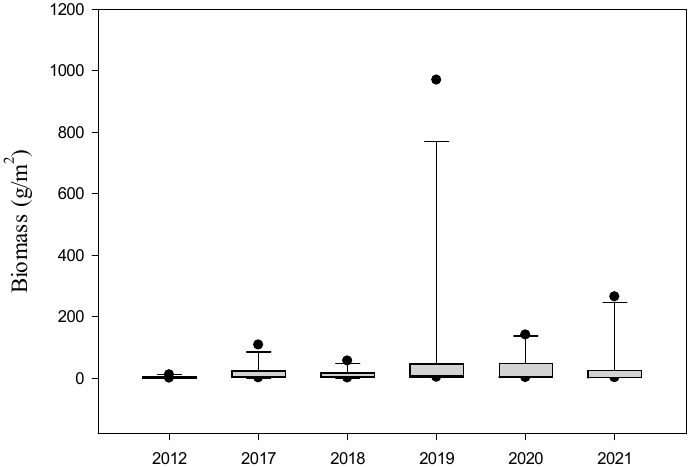
Figure 5. Comparison with previous studies of the East Sea (SES, south East Sea; NES, north East Sea; ES, East Sea; outer, area distant from land).